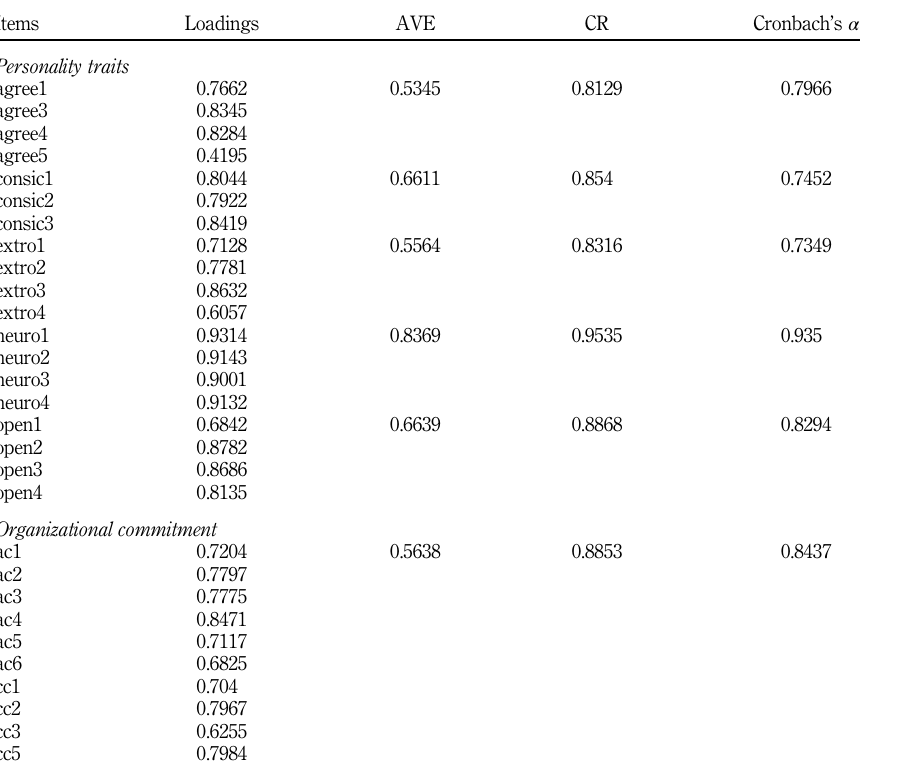
Table I. Quality